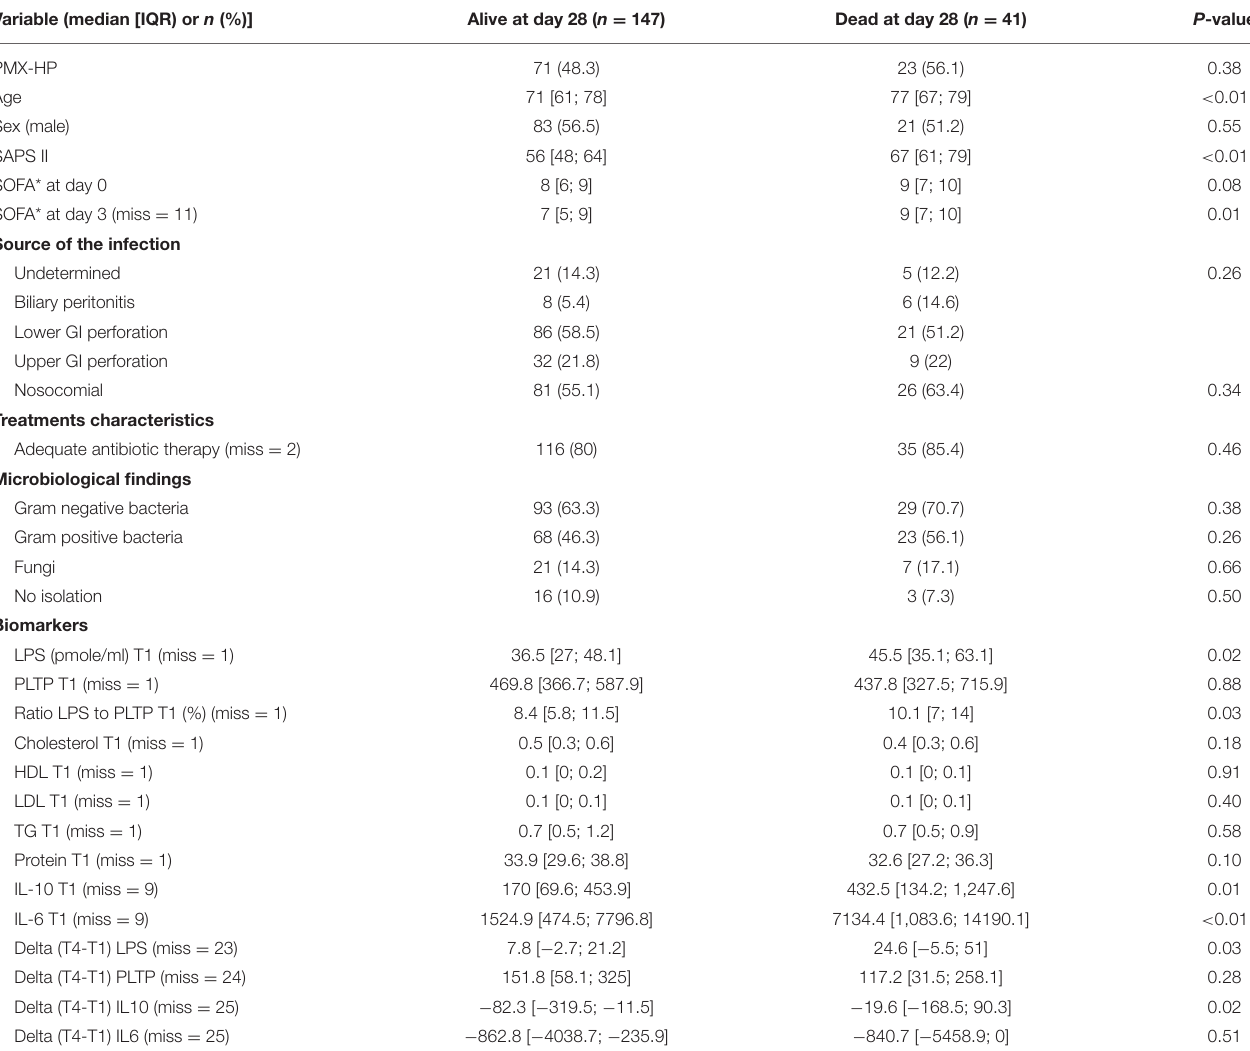
TABLE 2 | Comparison between the groups of patients alive or dead at day 28 ( n = 187). Variable (median [IQR) or n